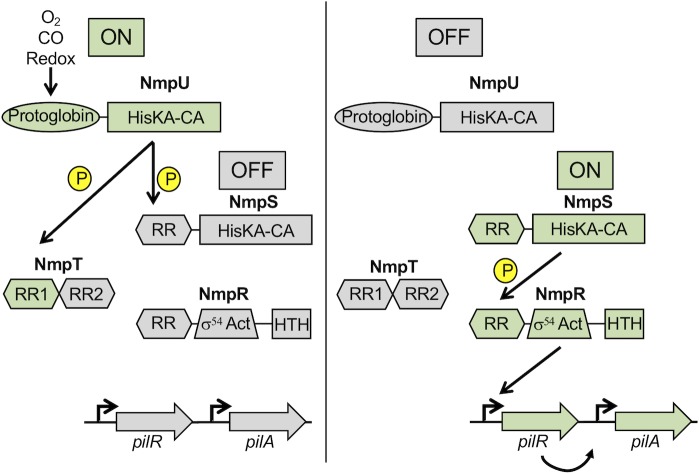
Model of the NmpRSTU multi-component signaling pathway.The presence of oxygen is sensed by the protoglobin domain of the SK NmpU. During high oxygen conditions, NmpU is “on”, autophosphorylating and subsequently phosphorylating the receiver domain of the hybrid RR-SK NmpS. We propose this would maintain NmpS in an “off” state. Additionally, the first receiver domain of NmpT serves as a phospho-sink for NmpU. When oxygen is limiting, perhaps in certain soil types/depths or during multi-cellular development, NmpU switches to an “off” state, leading to the loss of phosphorylation of NmpS and turning “on” the second branch of the pathway. NmpS phosphorylation of the RR NmpR under these conditions activates NmpR leading to modulation of the expression of pilR, which in turn regulates pilA expression influencing T4P-dependent motility.